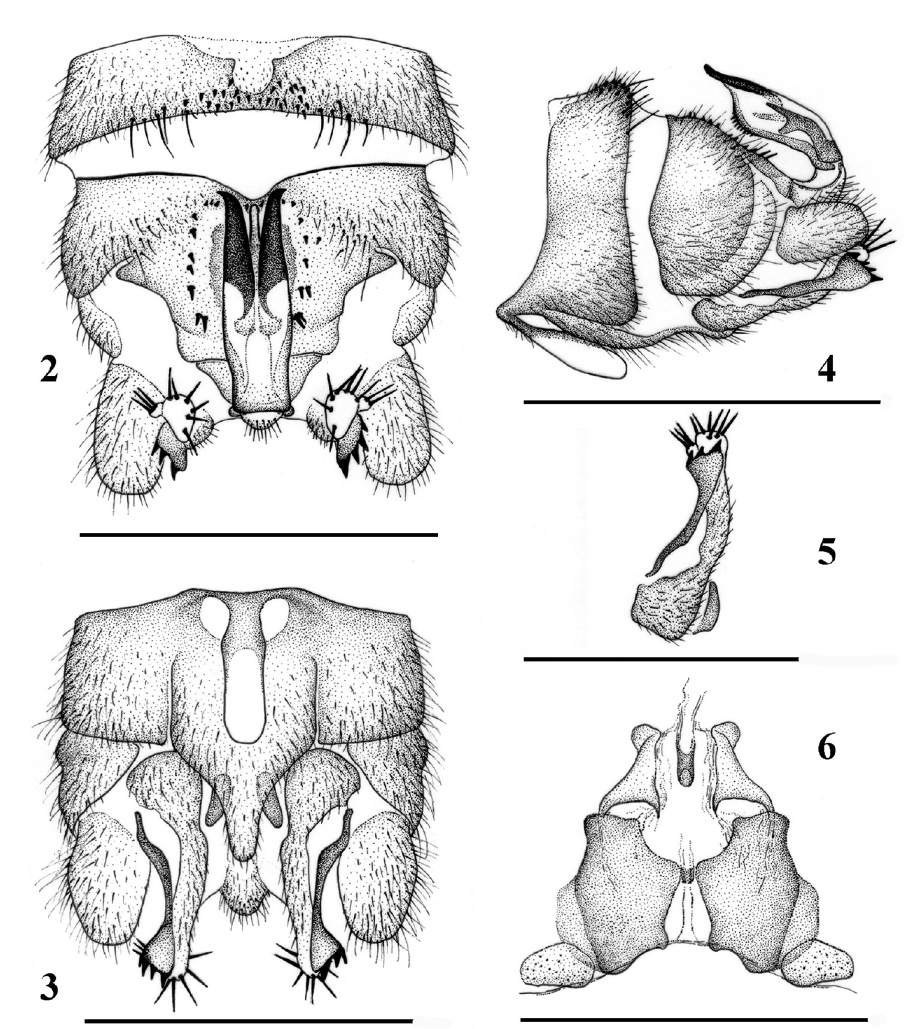
Figures 2–6. Amphinemura albicauda sp. n., terminalia of the adult paratypes. 2 Male terminalia, dorsal view 3 Male terminalia, ventral view 4 Male terminalia, lateral view 5 Male paraproct, oblique lateral view 6 Female inner genitalia, dorsal view. Scale bar: 0.5 mm. same size; outer lobe extends along with median lobe but shorter, well sclerotized, di- lated apex with 3 or 4 lateral, large teeth along outer margin. Female (Fig. 14): Forewing length 7.8 mm. Sternum VII produced in a broad semi- circular pregenital plate covering anterior half of subgenital plate; the plate is mostly pale with brownish posterior margin. Sternum VIII forms sclerotized subquadrate subgenital plate with narrowed anterior portion, medial notch is being broad but shallow medially; inner portion of the posterior lobes with small, sometimes indistinct secondary